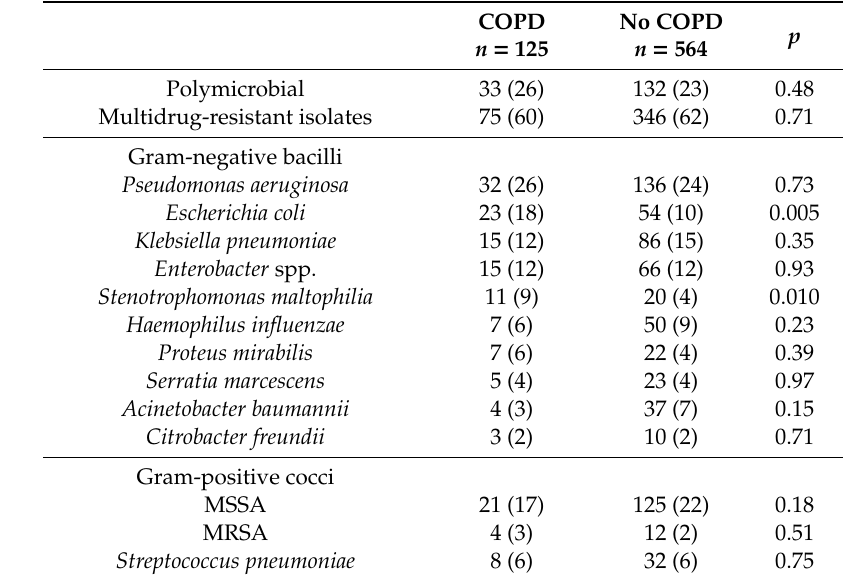
Table 3. Microbiological findings in COPD and non-COPD patients with ventilator-associated lower respiratory tract